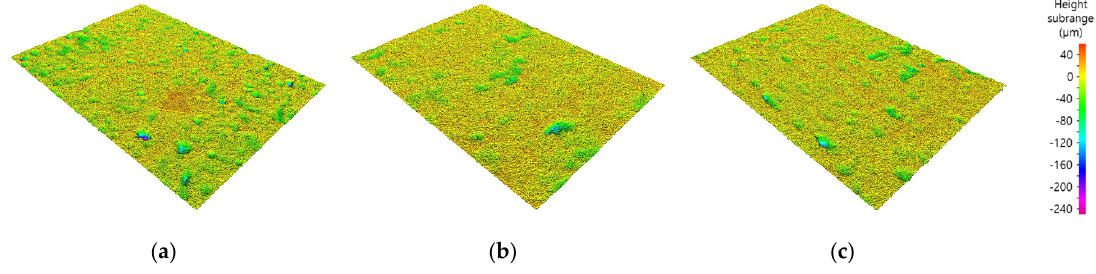
Materials 2019 , 12 , x FOR PEER REVIEW Figure 8. Surface roughness values of the HfC, TiC, and HfC / TiC coatings. Figure 8. Surface roughness values of the HfC, TiC, and HfC/TiC coatings.